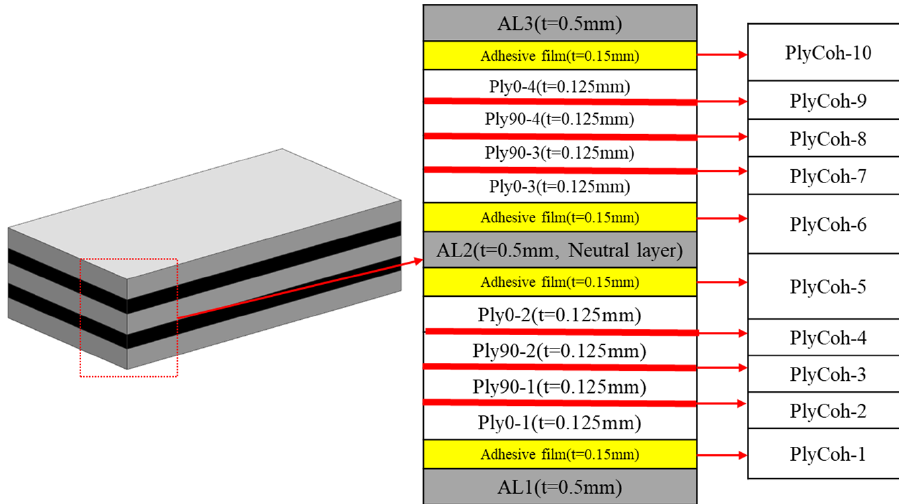
Table 3. Several parameters of the adhesive film.